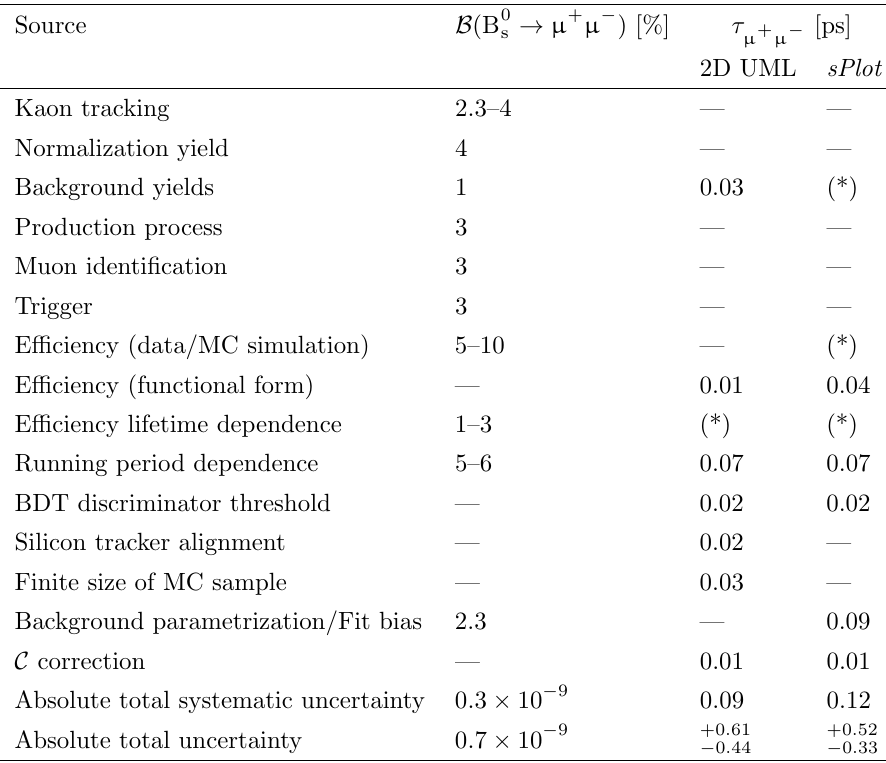
Table 2 . Summary of systematic uncertainty sources described in the text. The uncertainties quoted for the branching fraction B (B 0 ! (cid:22) + (cid:22) (cid:0) ) are relative uncertainties, while the uncertainties s for the e(cid:11)ective lifetime (cid:28) are absolute and are given for both the 2D UML and sPlot analysis (cid:22) + (cid:22) (cid:0) methods. The relative uncertainties in the upper limit on B (B 0 ! (cid:22) + (cid:22) (cid:0) ) di(cid:11)er for the background yields and parametrization, but have negligible impact on that result. The bottom rows provide the total systematic uncertainty and the total uncertainty in the branching fraction and the e(cid:11)ective lifetime measurements. Contributions that are included in other items are indicated by (*). Non- applicable sources are marked with